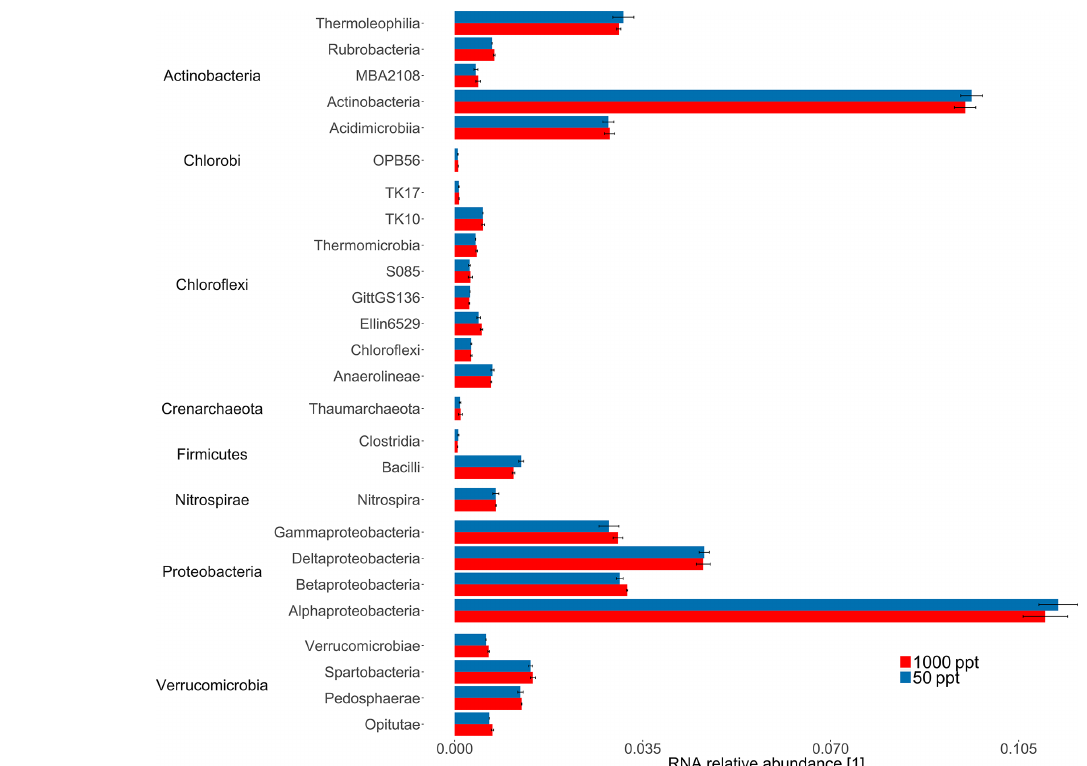
Figure 3. Taxonomic composition of the midlatitude corn field soil in Mainz, Germany, at 22% WFPS lab of the samples under 1000 or 50pptOCS. The 16S rRNA relative abundance for selected bacterial classes was normalized by the total number of assigned reads per sample. Classes with RNA relative abundance < 5 × 10 − 4 did not show significant differences and were not plotted. Error bars represent standard deviation. Asterisks represent statistically different values ( p value <